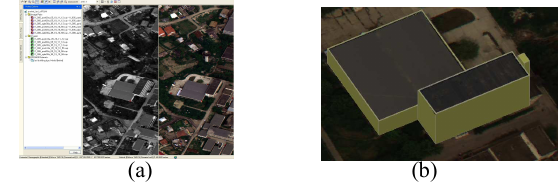
Figure 13. (a) PRO 600-ViewPlex window, (b) The 3D model of the